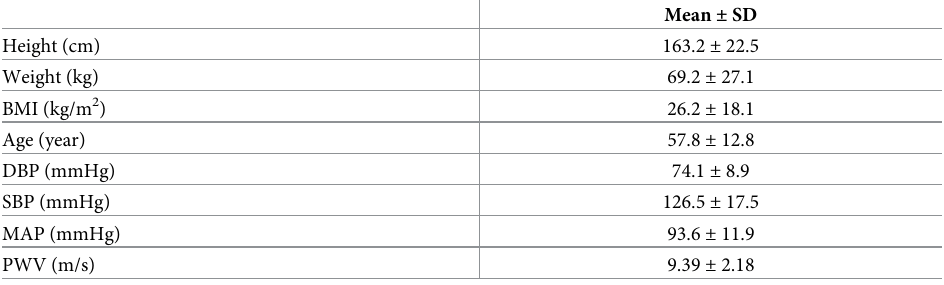
Table 1. Biological characteristics of the subjects from the Twins UK cohort (N = 3,082).